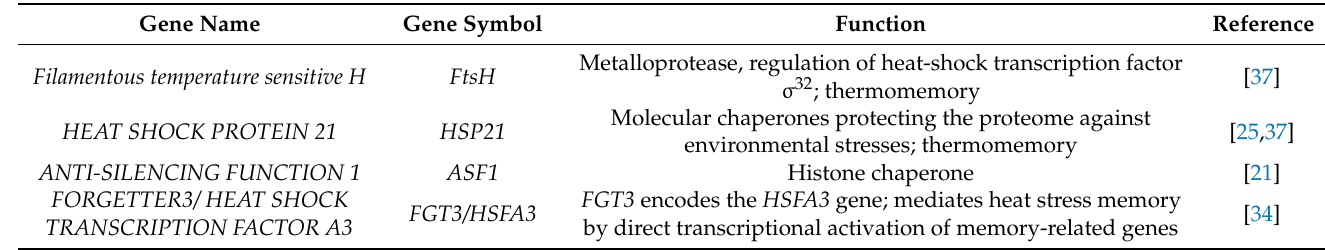
Table 2. Candidate gene and gene families for heat stress memory identified in Arabidopsis thaliana